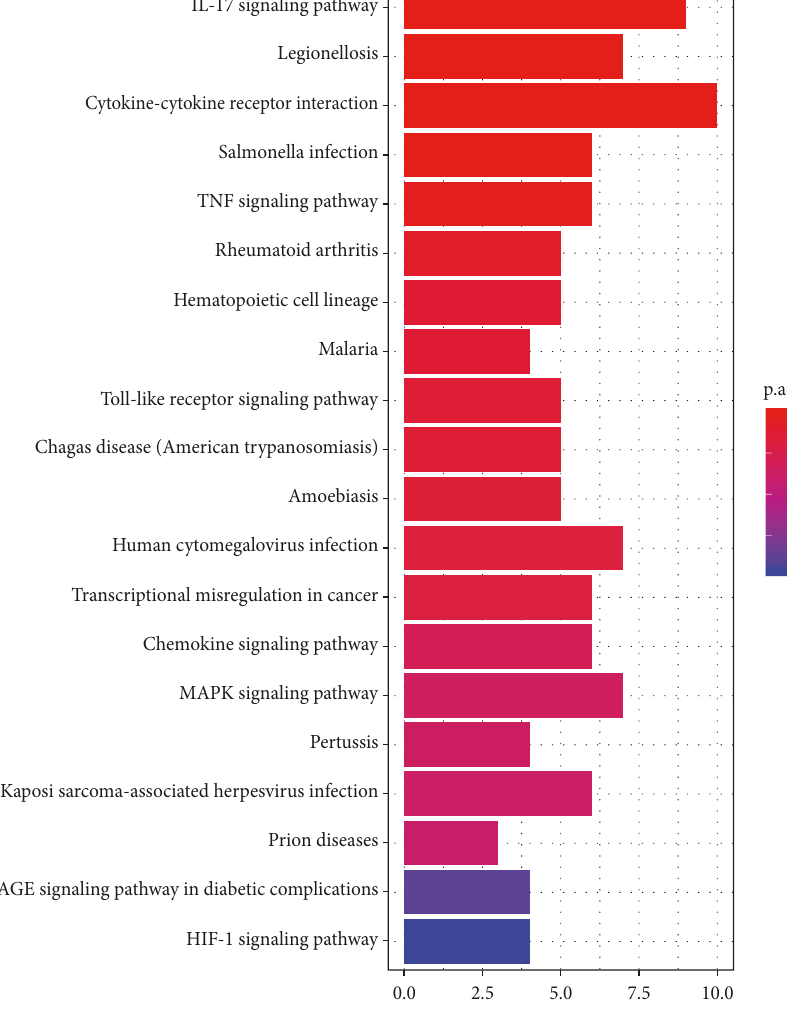
Figure 5: Top 20 KEGG pathway enrichment analyses of DEGs in AMI. Notes: X-axis indicates gene count; Y-axis represents different pathways. The column color reflects p -value: red represents the smallest value; blue represents the biggest value. The gradual color ranged from blue to red represents the changing process of p -value from big to small value. Abbreviations: AMI, acute myocardial infarction; DEGs, differentially expressed genes; KEGG, Kyoto Encyclopedia of Genes and